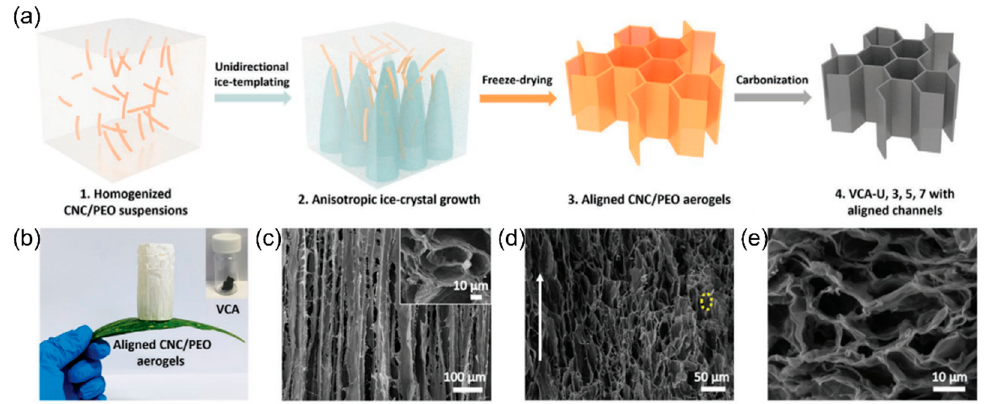
Figure 5. ( a ) Vertically aligned carbon aerogels synthesized by freeze drying. ( b ) The ultralight aligned cellulose nanocrystal (CNC)/polyethylene oxide (PEO) aerogels. ( c ) SEM images of cross- sectional and top view (inset) of the CNC/PEO aerogels. ( d ) Longitudinal view and ( e ) top view of the vertically aligned carbon aerogels. Reproduced with permission from ref. [61]. Copyright 2022, Wiley-VCH.